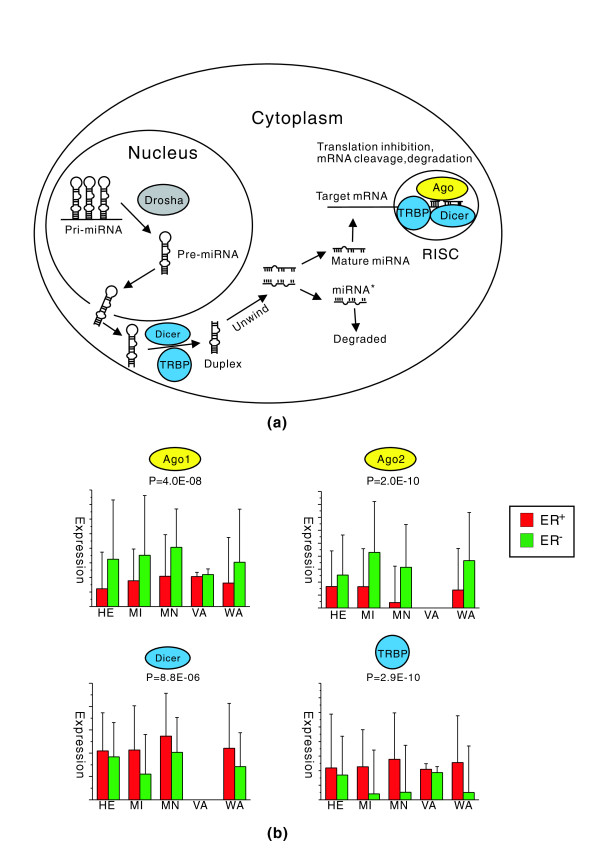
Differential expression of miRNA processing genes between ER+ and ER- breast cancer samples. (a) miRNA biogenesis and function pathway. Genes significantly up-regulated and down-regulated in ER- compared to ER+ samples are shown in yellow and cyan, respectively. A gene - for example, Drosha - is marked grey to denote that it shows no significant differential expression between ER- and ER+ samples. (b) Expression levels of Ago1, Ago2, Dicer, and TRBP in ER+ (red) and ER- (green) samples. The mean and the standard deviation of the expression levels for each gene are shown as a bar and vertical line, respectively. Data for a gene are not shown if it is missing from a dataset. The combined P-value for each gene is also shown.